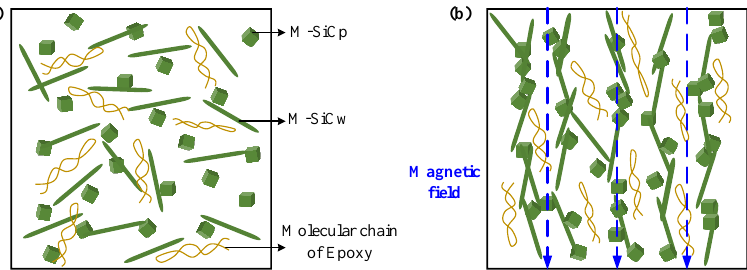
Figure 10. Effect of magnetic field action mode on the orientation of M-SiC filler and molecular chain inside M-SiC/EP composites. ( a ) Randomly oriented M-SiC/EP-N; ( b ) orderly oriented M-SiC/EP-C.